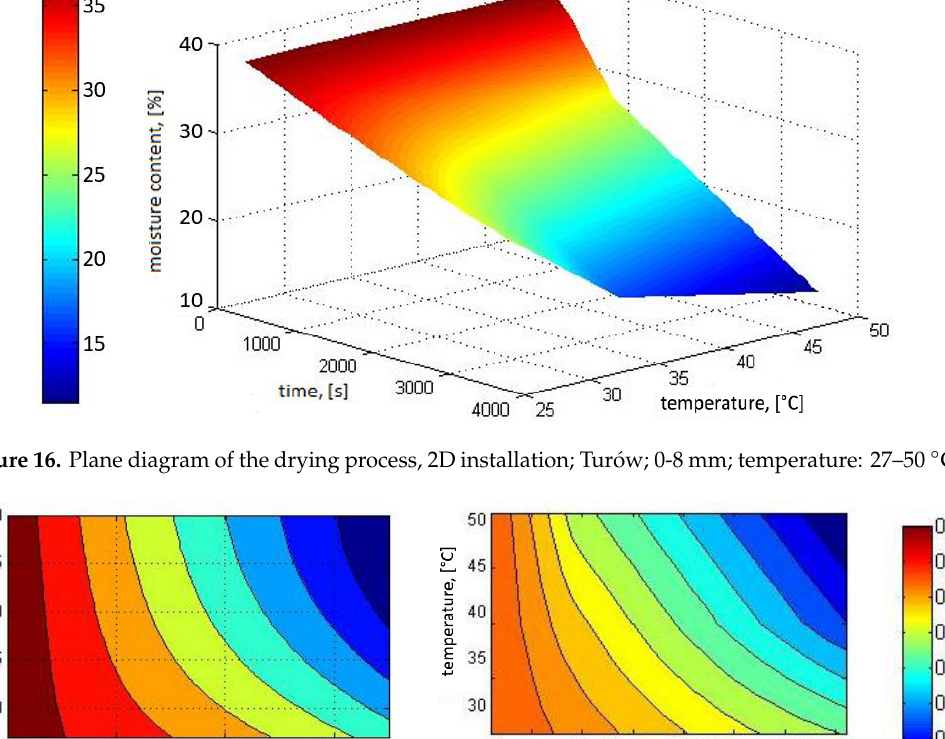
Figure 15. Plane diagram of the drying process, 2D installation; Bełchatów; 0–8 mm, temperature: 27– 50 °C.